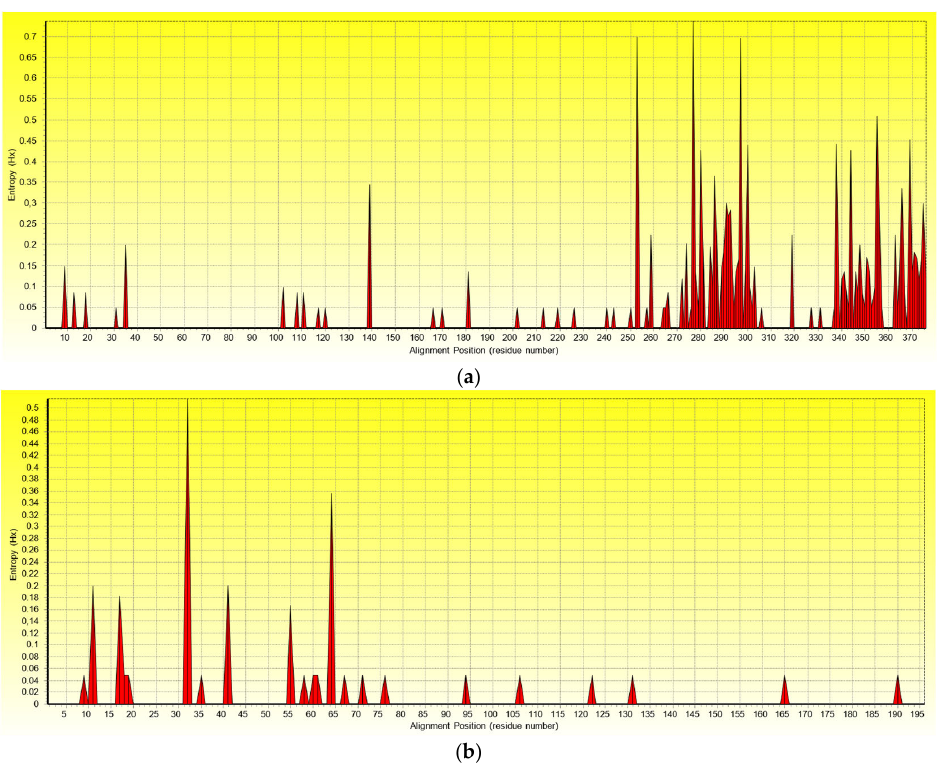
Figure 3. Graphical representation of the entropy of the ( a ) movement and ( b ) coat protein sequences generated using the entropy plot function (H(x)). The plot shows the variability of the different amino acid residues in alignment with Russian isolates of GPGV.